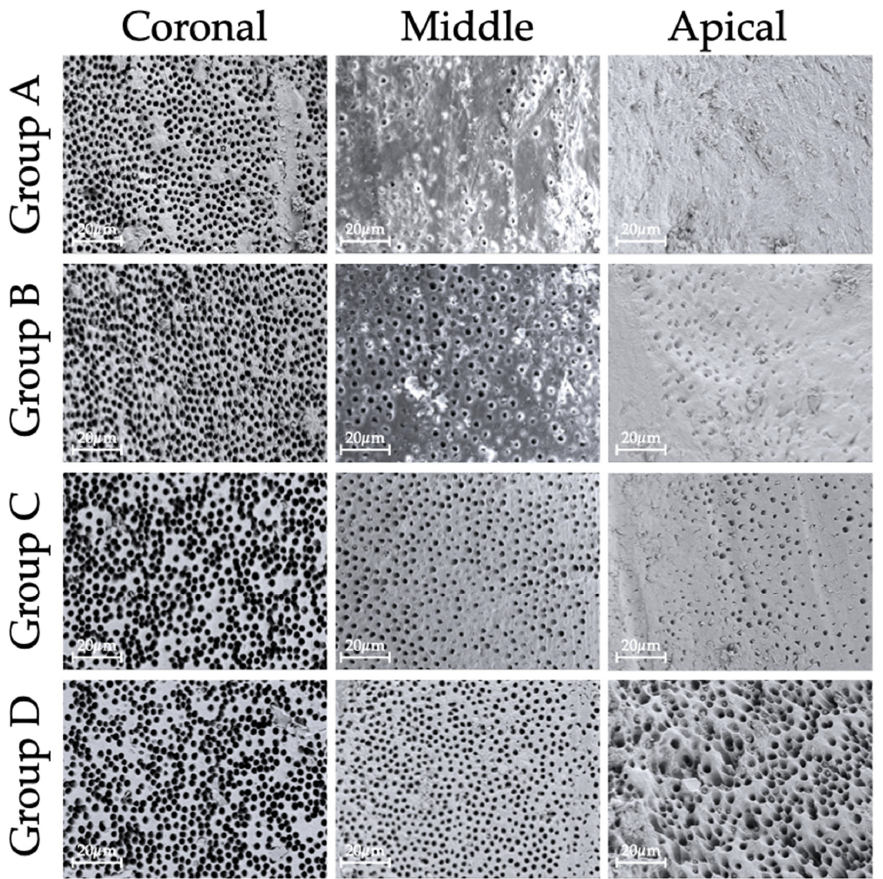
Figure 3. Representative scanning electron micrographs of the three canal thirds (coronal, middle and apical) of every irrigation system tested (2000X mag., 30 KV accelerated voltage).